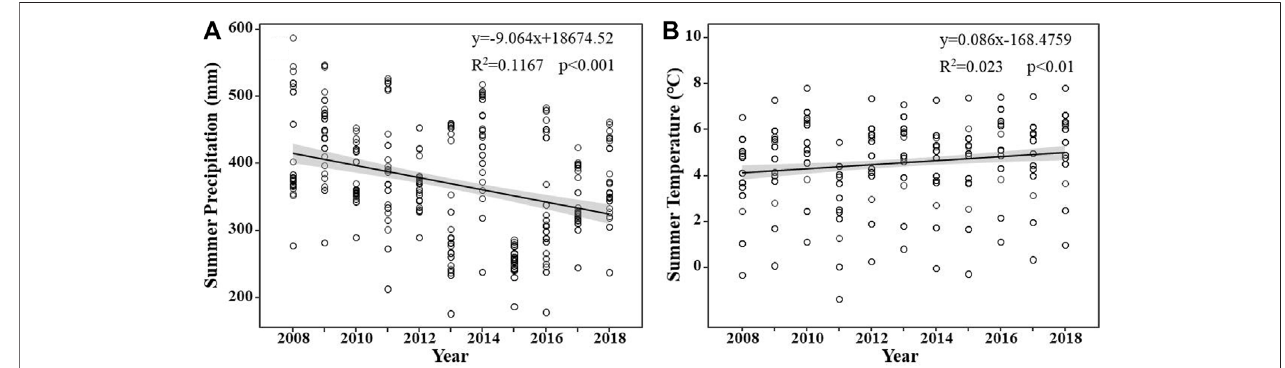
FIGURE 1 | Summer precipitation (A) and air temperature (B) between 2008 and 2018 in all the sites we surveyed in the permafrost region of the Tibetan Plateau. Solid circle, alpine meadow; blank circle, alpine steppe.